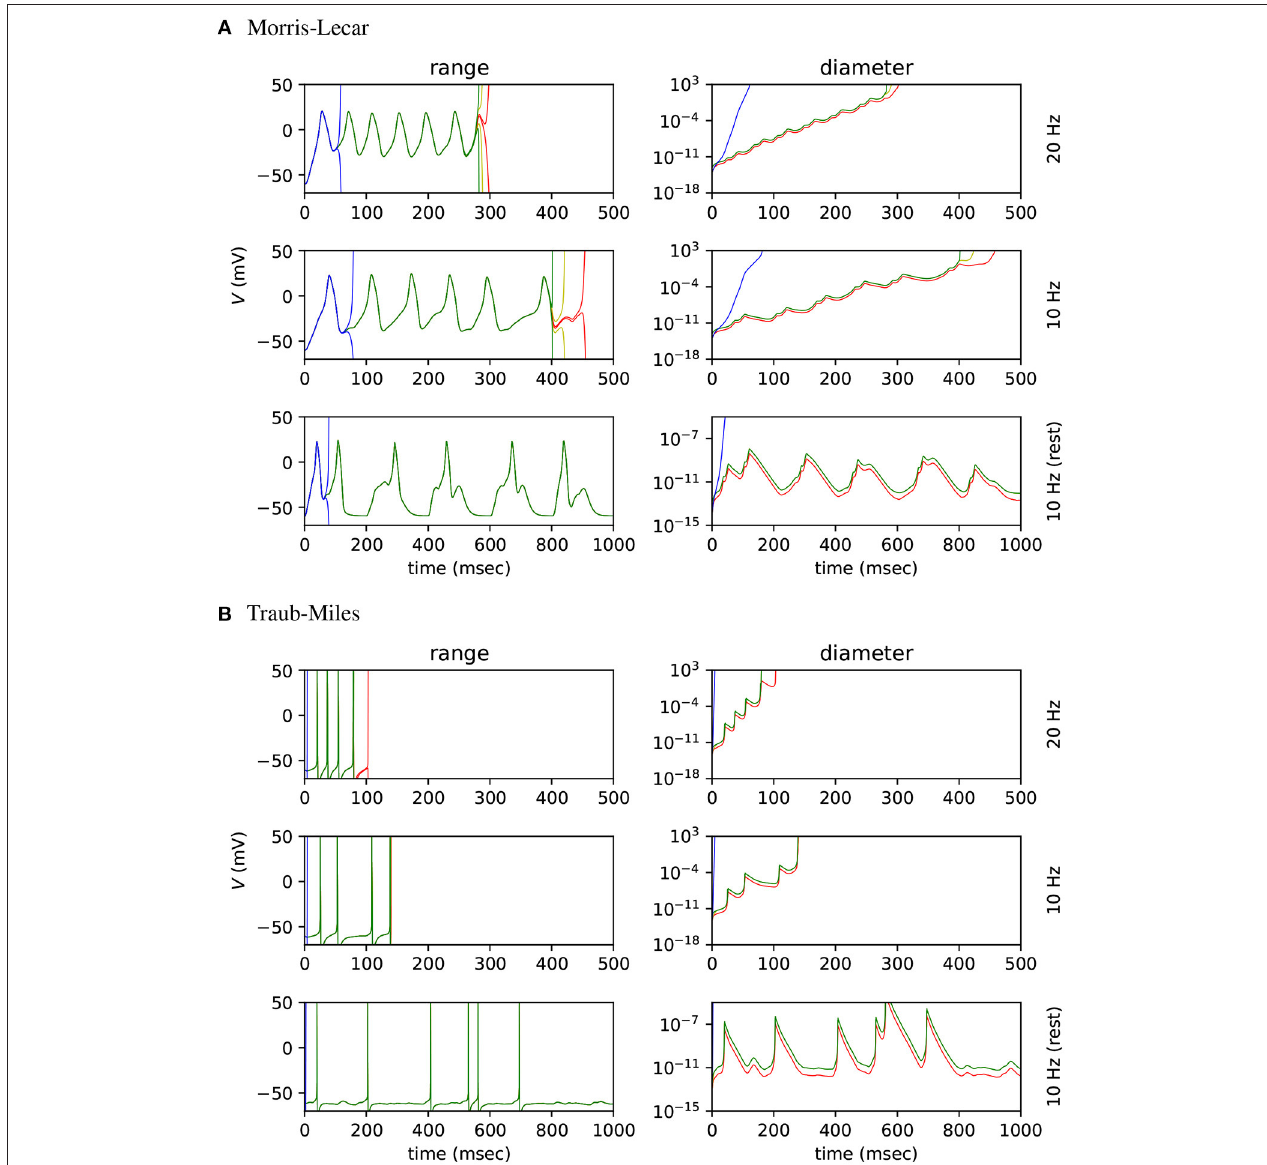
FIGURE 6 | Range and diameter of V in a fan in SNN model, where 50 Poisson input neurons project to a single output neuron. (A) Results for the Morris-Lecar model. (B) results for the Hodgkin-Huxley type Traub-Miles model. The three sub-panels show, respectively, results for constant input firing rate λ and for alternating 100 ms bursts of λ 10 Hz input and 100 ms of λ 0 Hz rest. Arpra methods AA (green), mixed IA/AA (yellow) and mixed Trimmed IA/AA (red) are = = compared to the MPFI (Revol and Rouillier, 2005) implementation of IA